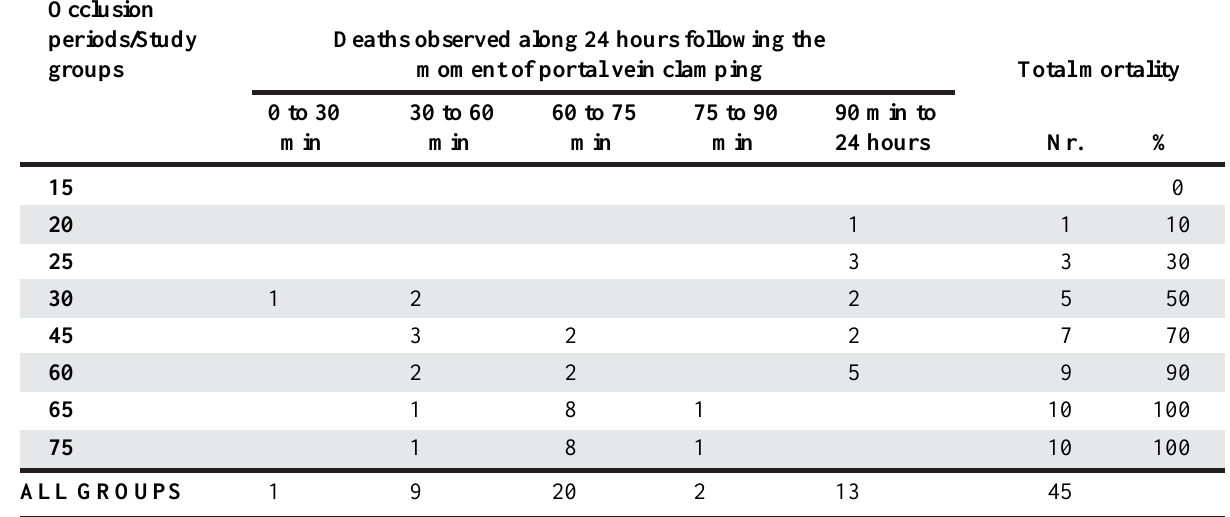
TABLE 1 - Number of deaths observed following the moment of clamping is shown for different periods of SPVO from 15 min (no mortality) to 75 min (100% mortality). Death caused by 20 and 25 min of SPVO occurred after 75 min following the clamping moment, whereas deaths resulting from SPVO periods of 30 min or longer occurred predominantly during the 75 min following the moment of PV clamping. Exact Fisher test. P=0.009.